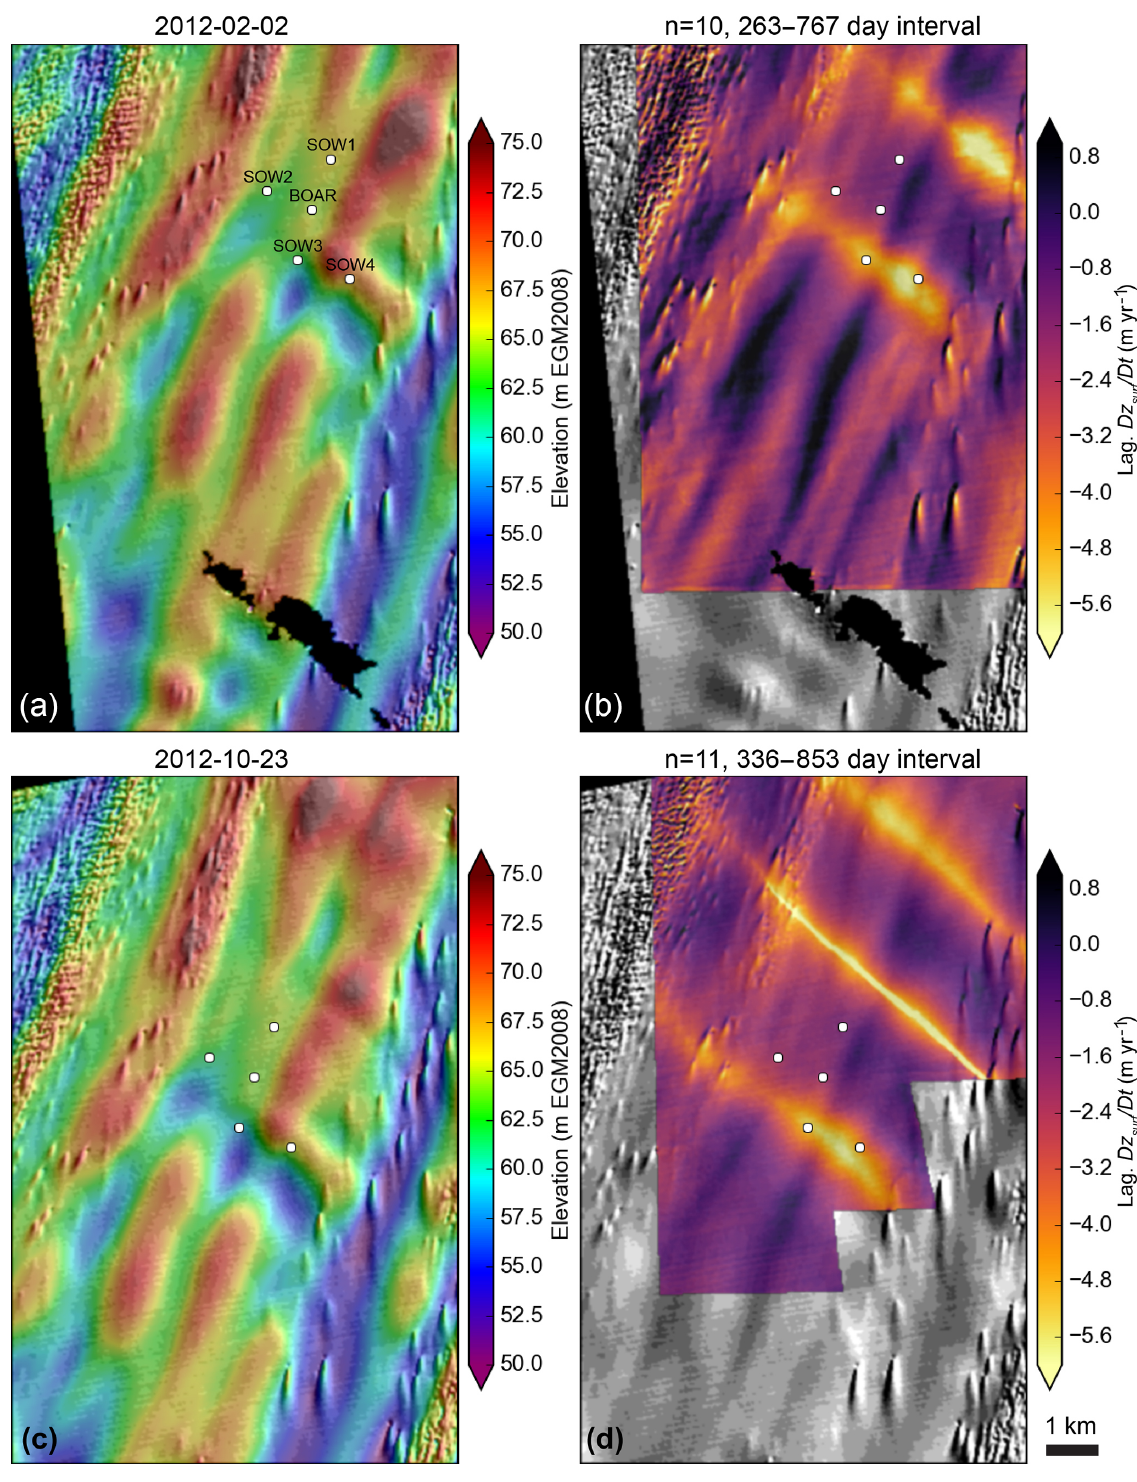
Figure 10. WorldView DEMs and composite Lagrangian D z surf / D t products generated using (a–b) initial DEM from 2 February 2012 and (c–d) initial DEM from 23 October 2012. Note enhanced thinning observed within transverse depressions and rift upstream of GPS array. The D z surf / D t maps are used to calculate basal melt rates (scaling factor of ∼ 9, e.g., D z surf / D t of ∼ 1myr − 1 corresponds to a basal melt rate estimate of ∼ 9–10myr − 1